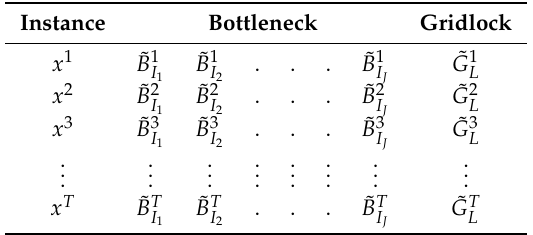
Table 2. Observation instances of observed and computed time series.